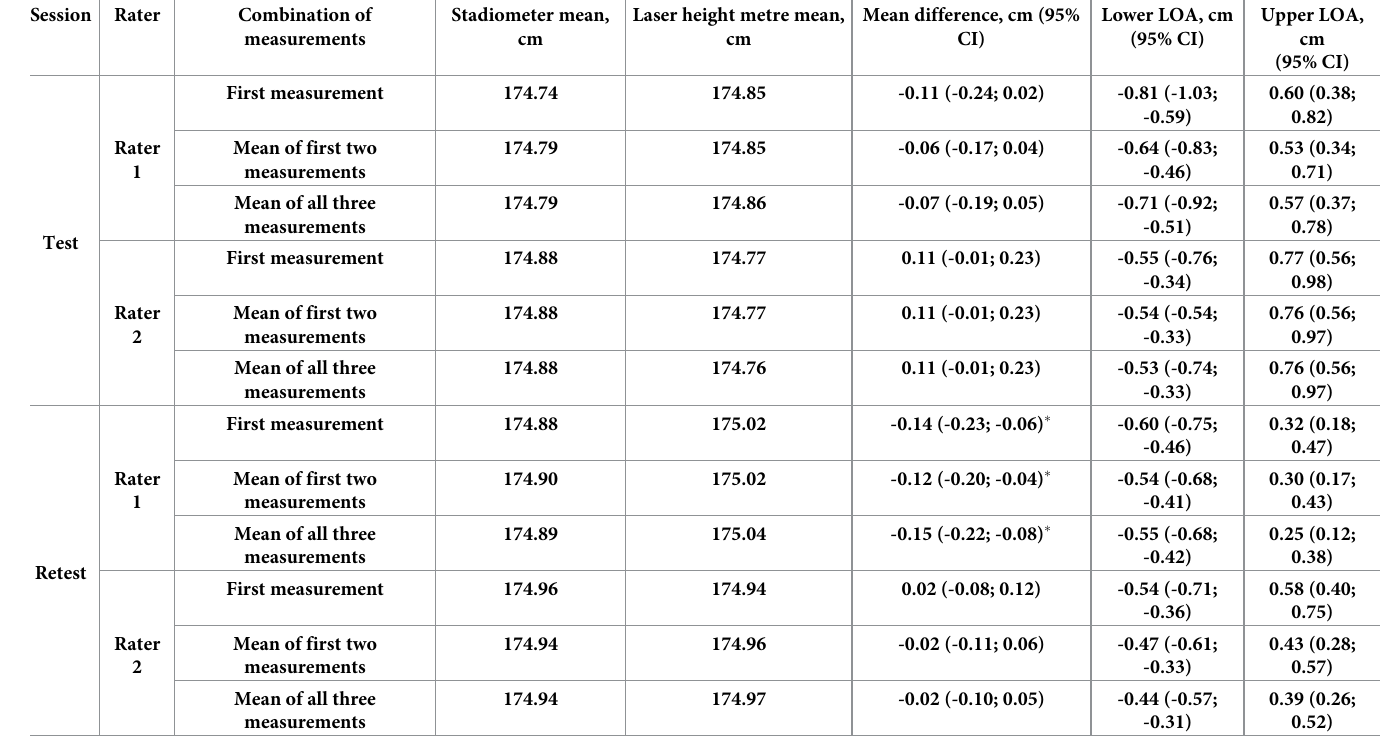
Table 3. Agreement between laser height metre and stadiometer on each rater and test session (n =